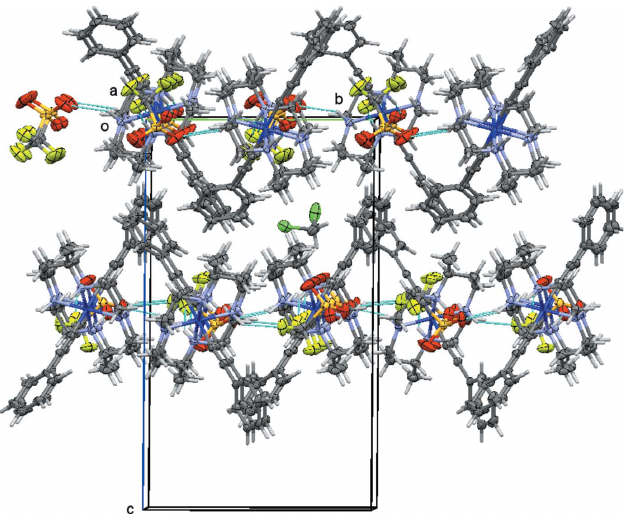
Figure 7 Hydrogen-bonding interactions in 1 , showing a segment of the ribbons formed by N—H (cid:2)(cid:2)(cid:2) N, N—H (cid:2)(cid:2)(cid:2) O, and N—H (cid:2)(cid:2)(cid:2) Cl hydrogen bonds (symbolized by dashed turquois lines). Views are slightly tilted down the a axis (left) and the b axis (right). C—H (cid:2)(cid:2)(cid:2) O interactions, omitted for clarity, connect parallel ribbons along the a -axis direction. Disorder of methanol molecules is omitted for clarity.